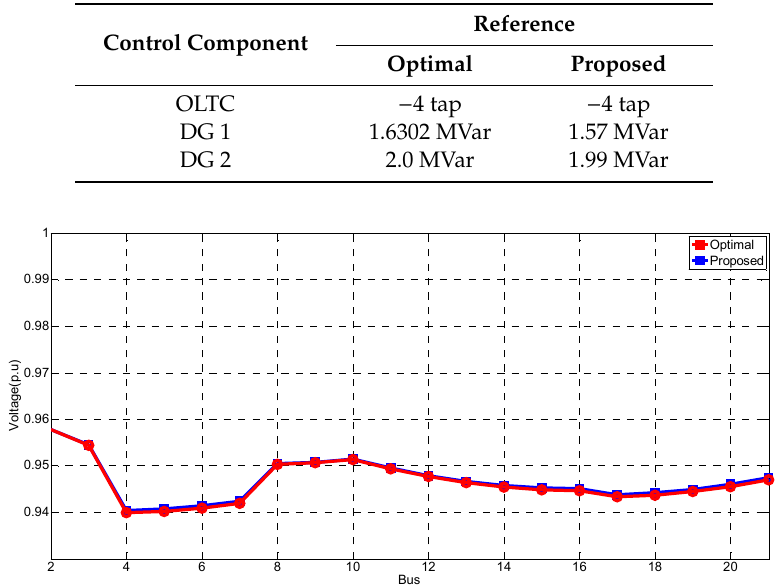
Figure 23. Load prediction schedule for simulation. 4.2.1. Tap Scheduling Results for Case 1 The “Opt” graph in Figure 15 is determined by the voltage control for nominal voltage. Based on the optimal tap position, the result of “+1 tap” and “ − 1 tap” can also be derived. The reactive power result is obtained again at each tap position. The PI weight for tap change is set to 0.1, which is significantly larger than the PI at each tap position. Finally, the schedule readjustment results confirm that 1 tap change occurs in a full schedule. In other words, with our scheme 10 tap changes are reduced to 1 tap change. The hourly PI at each tap position is shown in Figure 16. The reactive power reference is calculated from the tap schedule as shown in Figure 24. The maximum reactive power output of DG 1 is shown in Figure 24 due to its location in the upper area of the distribution network. The results from the adjustment of the tap schedule are summarized in Table 7.